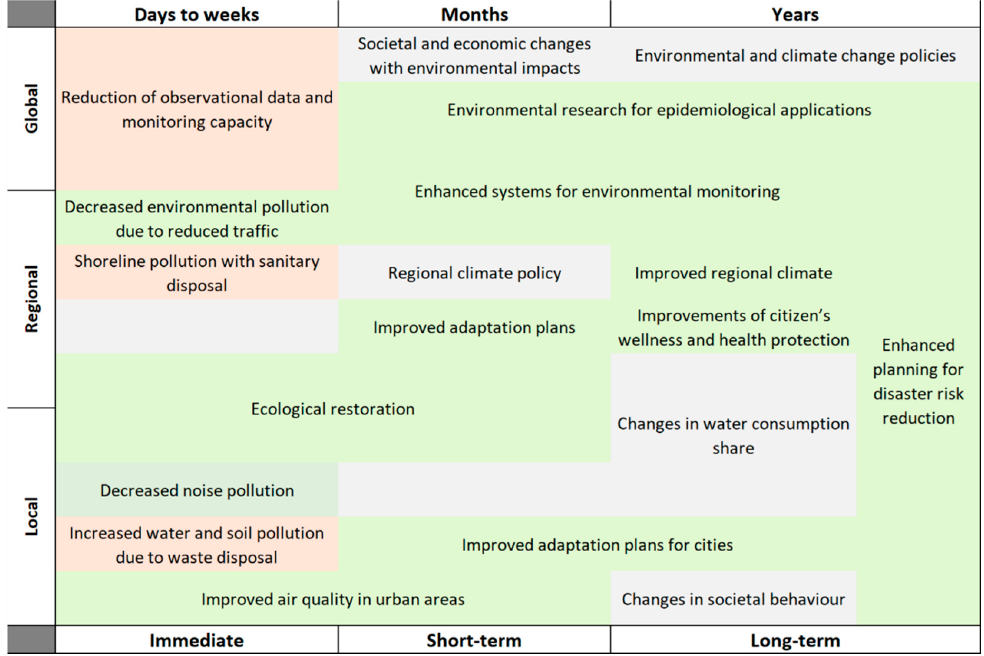
Figure 2. Matrix of observed and potential impacts of COVID-19 on environment and climate change. Red blocks are negative impacts, green are positive and grey stands for neutral effects.